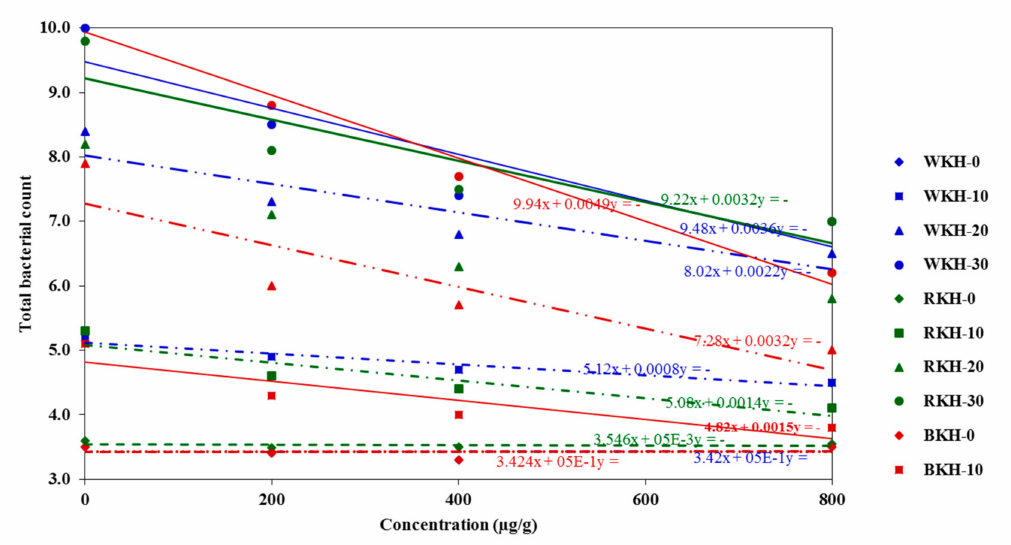
Figure 8. The bacterial load in chicken meat supplemented with BKH, RKH, and WKH during storage period expressed by trendline regression curves for results